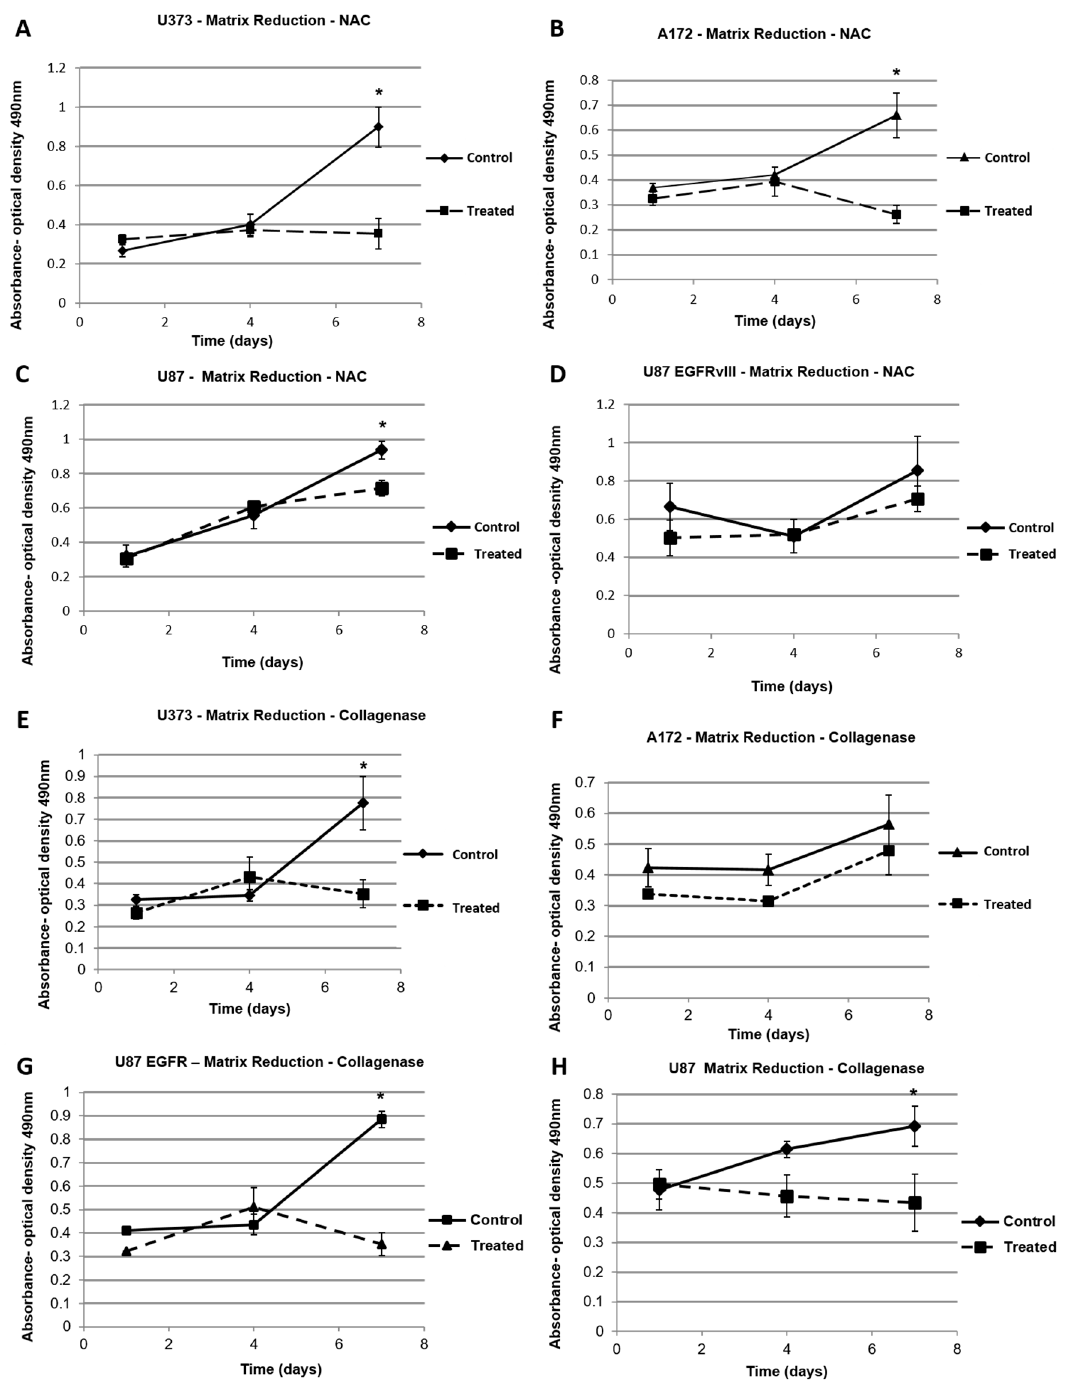
Figure 6. Targeting elastic modulus by using N -Acetyl- L -Cysteine to break disulfide bonds in PEGSSDA cross-linked hydrogels, and resulting proliferation rates: ( A ) U373 cells; ( B ) A172 cells; ( C ) U87 cells and ( D ) U87 EGFRvIII cells. Targeting elastic modulus with collagenase/hyaluronidase to degrade the hyaluronic acid (HA) and gelatin components in S3 hydrogels: ( E ) U373 cells; ( F ) A172 cells; ( G ) U87 cells and ( H ) U87 EGFR viii cells. * Denotes p value is less than 0.05.